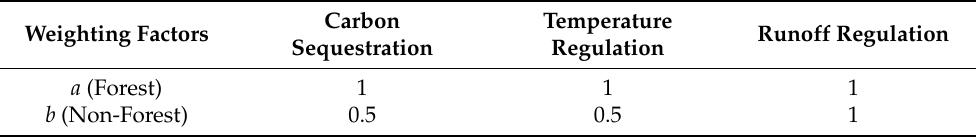
Table 1. Weighting factors in terms of contribution of each sub-class to each selected landscape service (adapted from